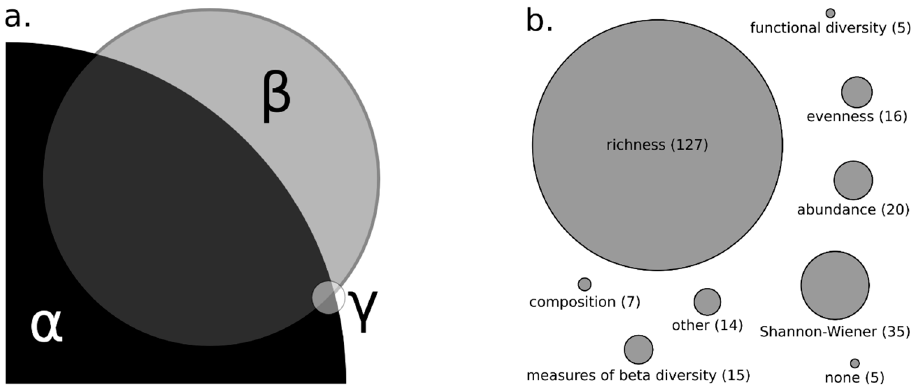
Figure 2. Proportion of reviewed publications utilizing alpha-diversity (81%), beta-diversity (37%), and gamma-diversity (4%) as a scale for biodiversity comparison ( a ). Overlap of circles representing diversity types indicates the number of studies that used multiple metrics. Alpha-diversity refers to local diversity, beta-diversity as turnover between local communities, and gamma-diversity as regional diversity. Measures of biodiversity used to infer relationships between stream size and biodiversity ( b ). Measures of beta-diversity include dissimilarity and turnover. Other includes measures such as biomass, genetic diversity, nestedness, and occurrence.